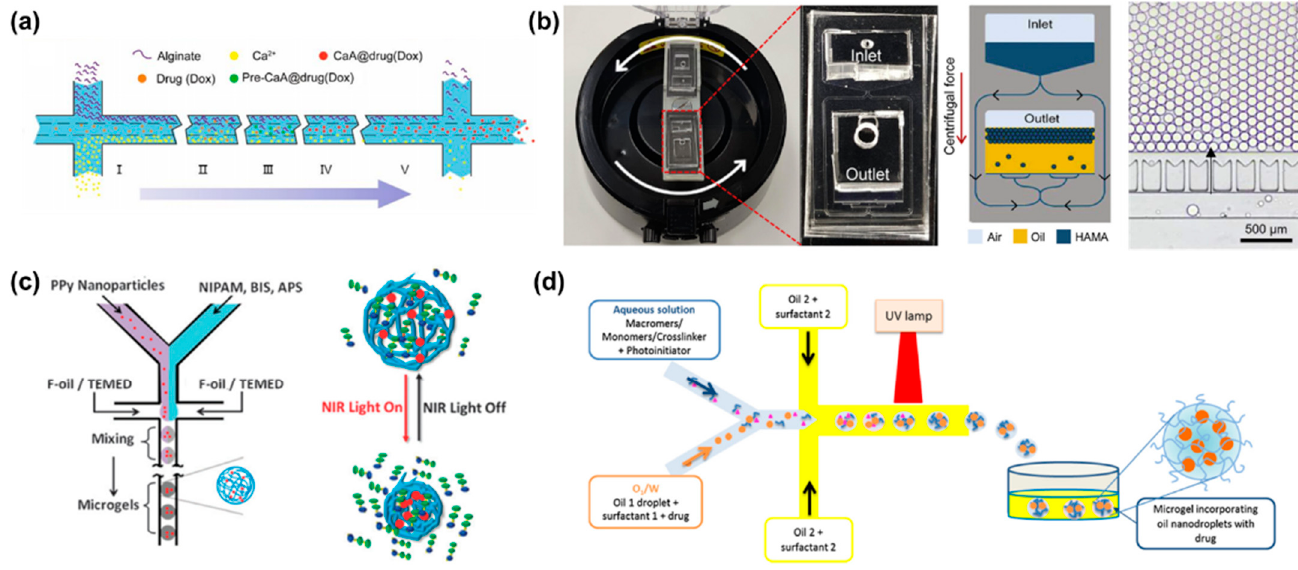
Figure 2. ( a ) Schematic illustration of microfluidic diffusion mixing mode, where alginate and Ca 2+ ions diffuse into the intermediate channel and mix to form nanoparticles. Reproduced with permission [57] . Copyright 2019, Switzerland. ( b ) Photograph of a portable centrifugal microfluidic system assembled on a commercial centrifuge. Schematic diagram of microdroplet formation during centrifugation, and optical micrographs of microdroplets prepared in the microfluidic device. Reproduced with permission [60]. Copyright 2020, Elsevier. ( c ) Schematic illustration of PPy nanoparticles mixed with PNIPAM and served as photosensitive drug carriers fabricated with droplet microfluidics. Reproduced with permission [66]. Copyright 2013, Royal Society of Chemistry. ( d ) Schematic illustration of the preparation of biodegradable HA microgels with O/W/O as a template. Reproduced with permission [67] . Copyright 2017, Elsevier.